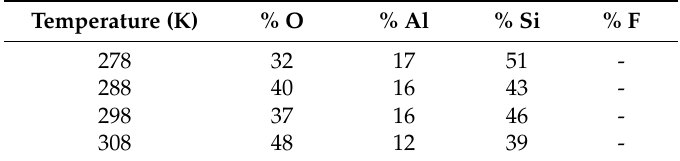
Table 2. EPMA analysis, in at %, corresponding to leaching residues obtained at different temperatures. Temperature